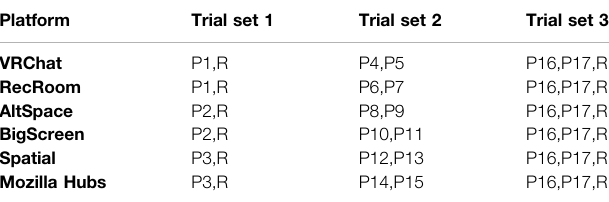
TABLE 3| Arrangementofparticipants (P1-P17) andplatforms. NotethatRrefers to the researcher (one of the authors).